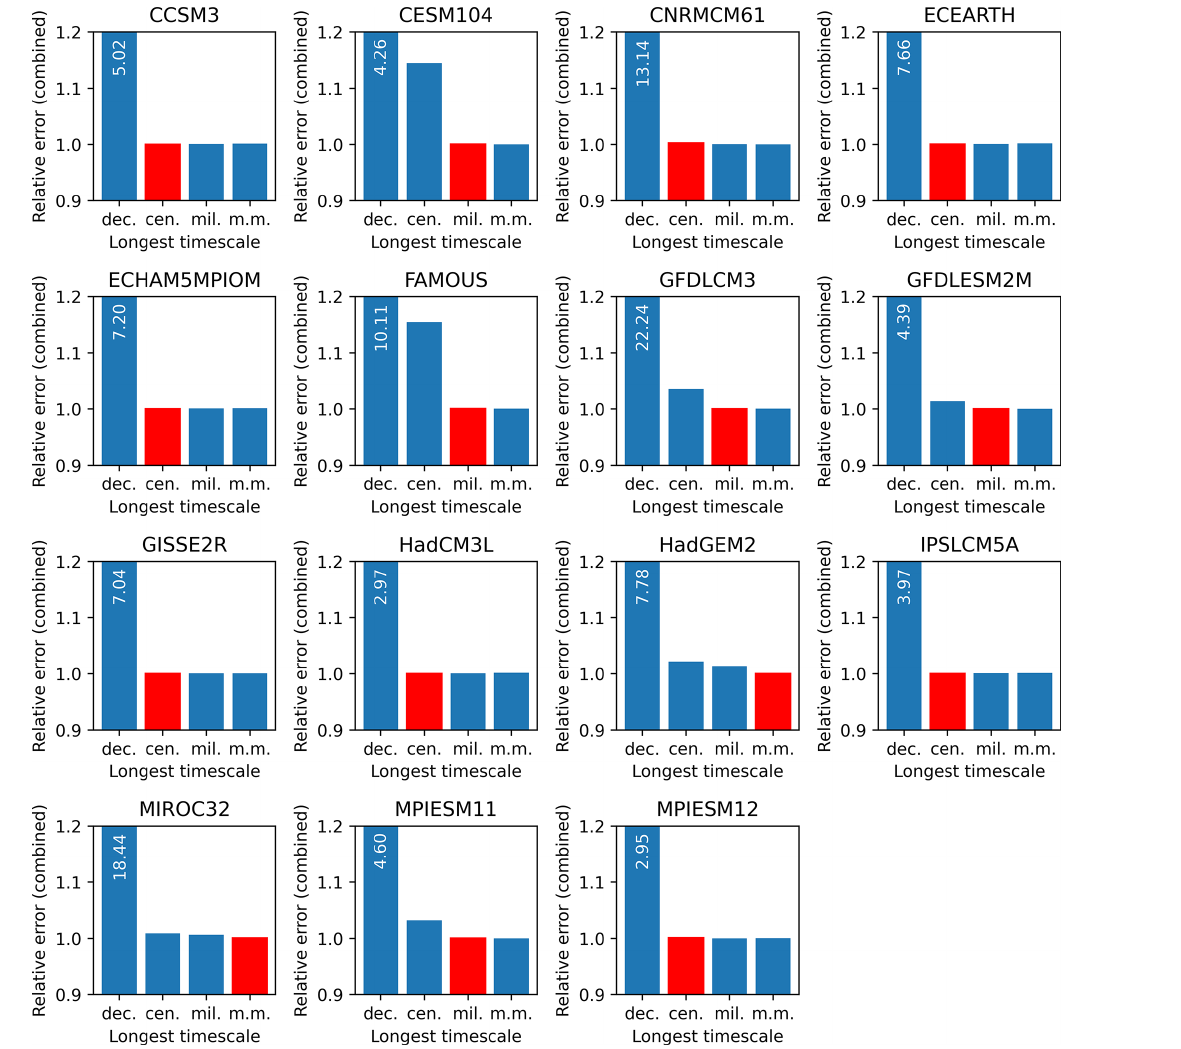
Figure 1. Illustration of the root mean square error for the fit to global mean temperature and net TOA radiative balance using models allowing for a range of timescales. Dec., Cen., Mil. and m.m. are decadal-, centennial-, millennial- and multi-millennial-timescale models, respectively. RMSE values for each variable (NET and GMT) are normalized relative to the best overall fit for that variable, each multiplied by 0.5 to give a combined error. The shortest timescale model with errors within 0.5% tolerance of the overall best performing model is illustrated in red. Included modes and parameter priors are detailed in Tables 1 and 2. In cases where the error is truncated by the vertical axis, the value is printed in